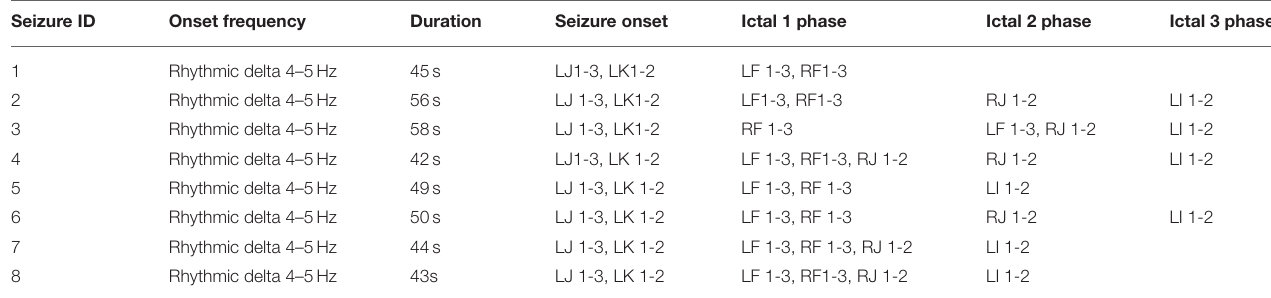
TABLE 2 | Details of seizure events recorded during stay of patient in epilepsy monitoring